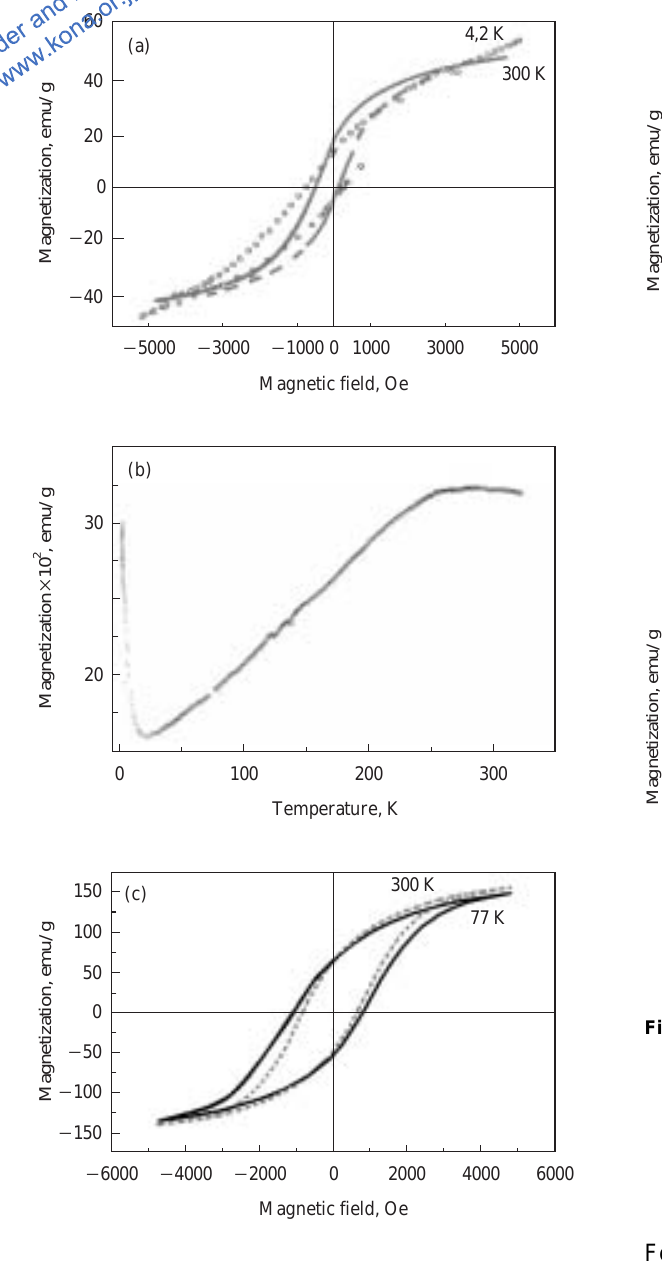
Fig. 6 (a, c) Hysteresis loops and (b) Variation of the magnetic moment with temperature of the Co (cid:5) UPTFE synthesized from acetate (a, b) and formate